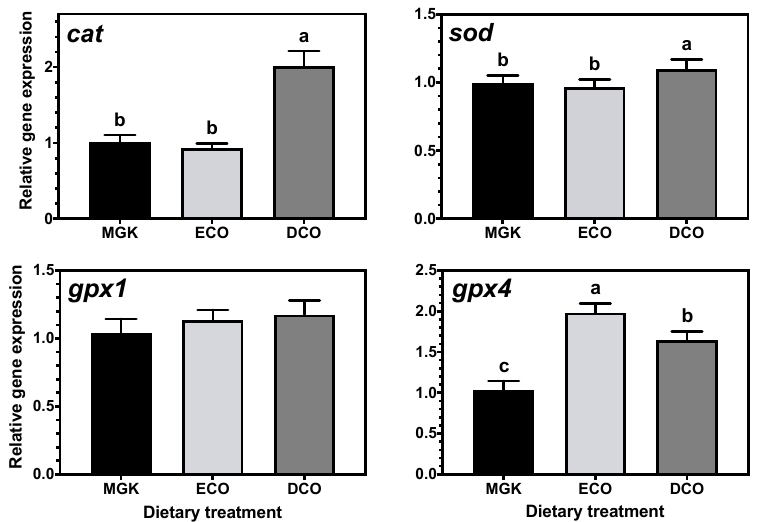
Figure 7. Nutritional regulation of catalase ( cat ), superoxide dismutase ( sod ) and glutathione peroxidase 1 and 4 ( gpx1 and gpx4 , respectively) gene transcription in liver of Atlantic bluefin tuna ( Thunnus thynnus L.) juveniles fed a reference diet Magokoro ® (MGK) and two test diets containing either EPA (ECO) or EPA + DHA (DCO) oils from transgenic Camelina sativa seeds. Values are normalised expression ratios to MGK reference diet and are means ± SD ( n = 6). Values with different superscript letters are significantly different (one-way ANOVA and Tukey test; p < 0.05).